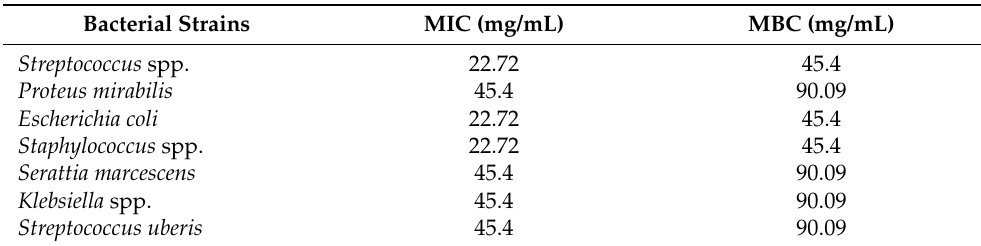
Table 1. Minimum inhibitory concentrations (MICs) and minimal bactericidal concentrations (MBCs) of EO-based formulation against mastitis-associated pathogens. Bacterial Strains MIC (mg/mL) MBC (mg/mL) Streptococcus spp. 22.72 45.4 Proteus mirabilis